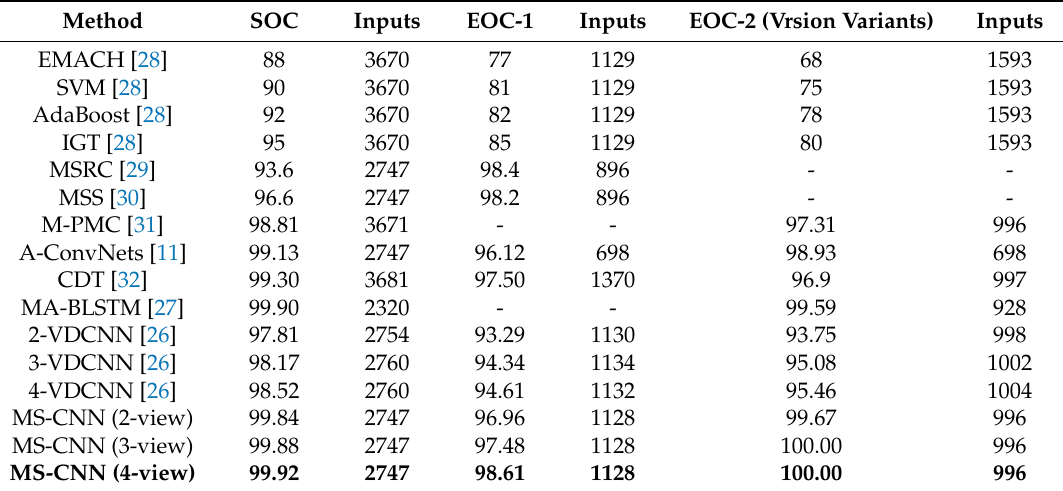
Table 12. Recognition accuracy comparison of the MS-CNN and other